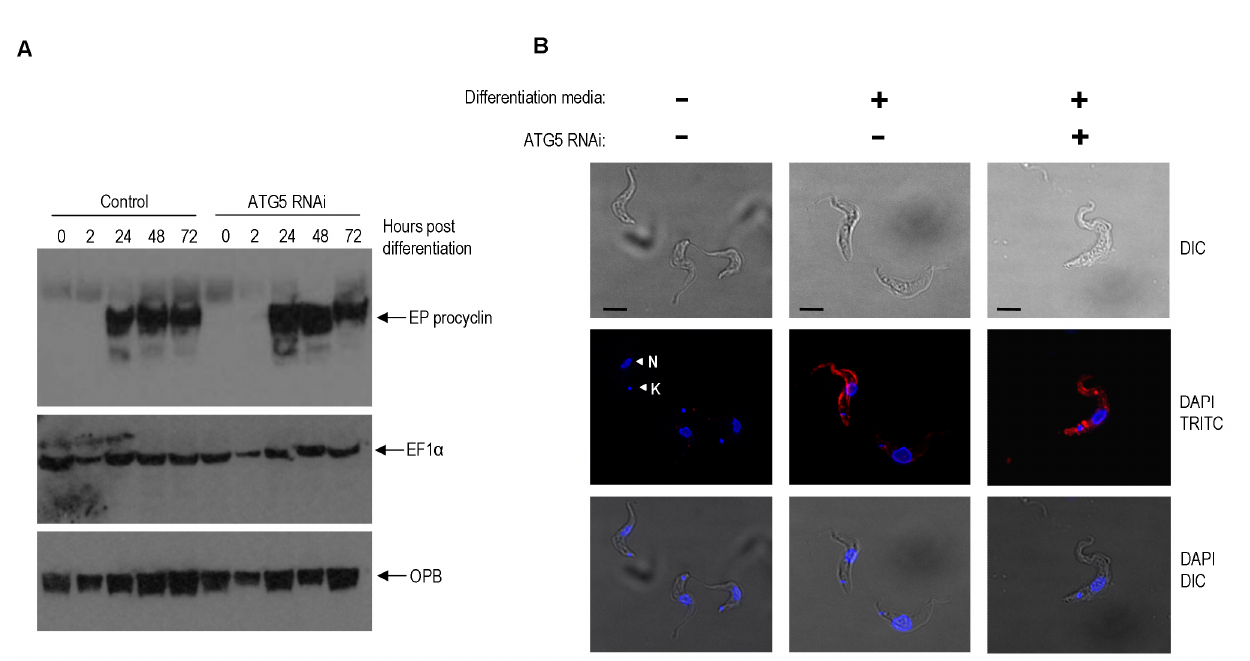
FIGURE 5: Differentiation in bloodstream form RNAi autophagy mutants. Differentiation of BSF YFP-ATG8.2 ATG5 RNAi mutants (48 h after tet induction) was stimulated by switching cells to differentiation media and incubating at 27 o C. Cells were analysed for characteristic PCF markers such as EP-procyclin expression and nuclear/kinetoplast re-configuration. (A) Western blot of whole cell extracts taken at specific times after induction of differentiation and probed with EP-procyclin, anti-EF1 a and anti-OPB. (B) Fluorescent microscopy of cells 24 h post induction, fixed and labelled with anti-EP procyclin (red) and DAPI (blue) to show changes in the nuclear configuration (nucleus, N and ki- netoplast, K). Scale bar 5